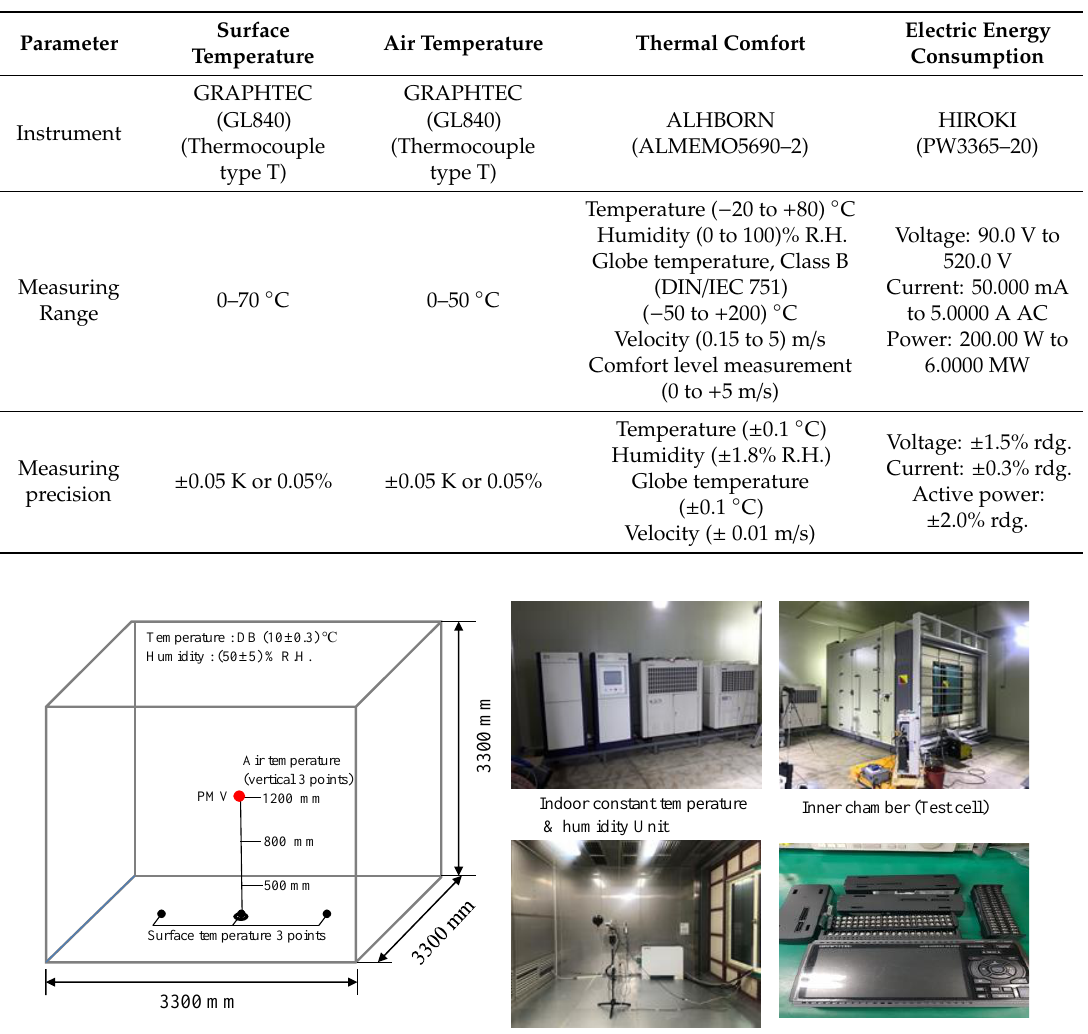
Figure 5. Experimental set-up: test cell with the environment facility and measurement points and equipment.